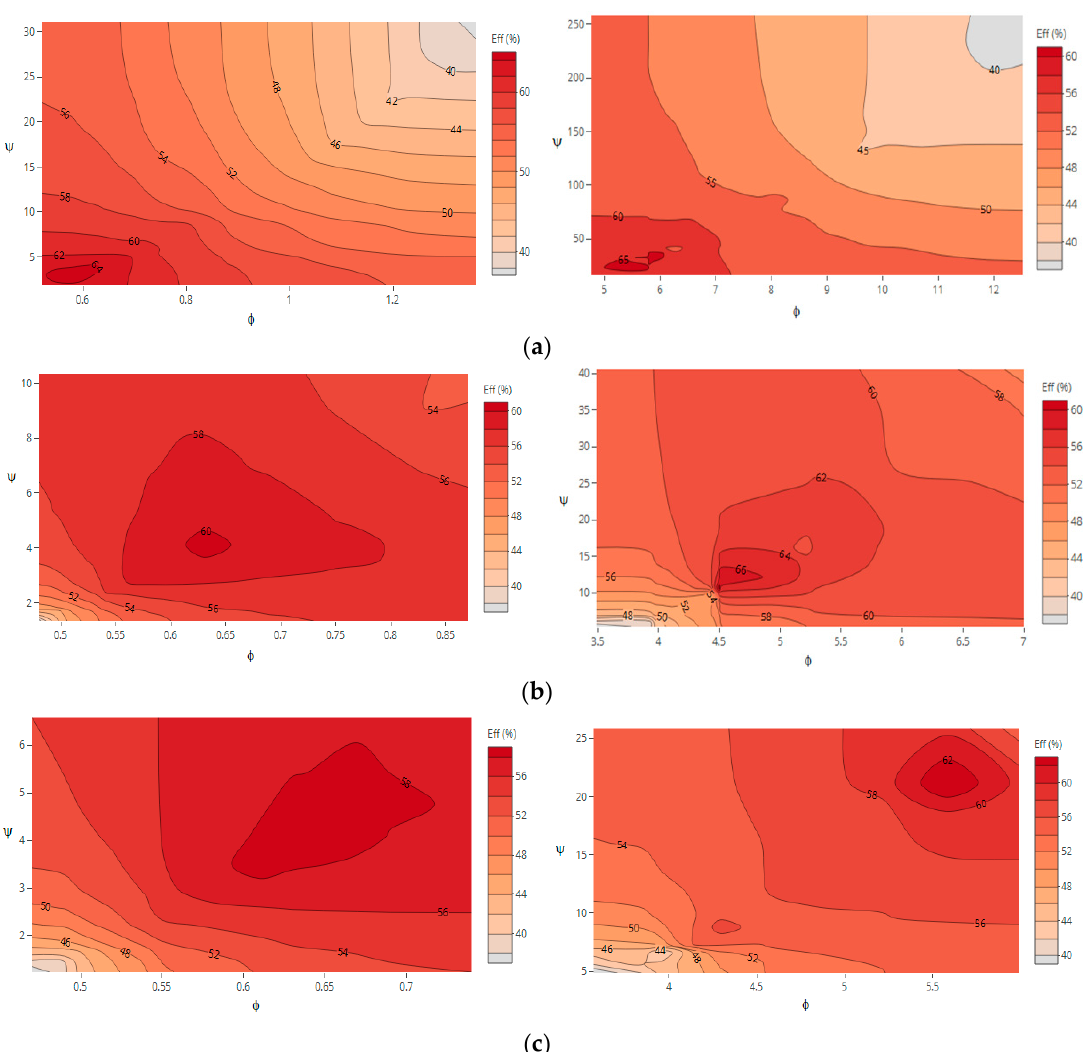
Figure 13. Efficiency hill charts for D = 85 mm ( left ) and D = 170 mm ( right ) for: ( a ) N = 750 rpm; ( b ) N = 1500 rpm; ( c ) N = 1750 rpm.